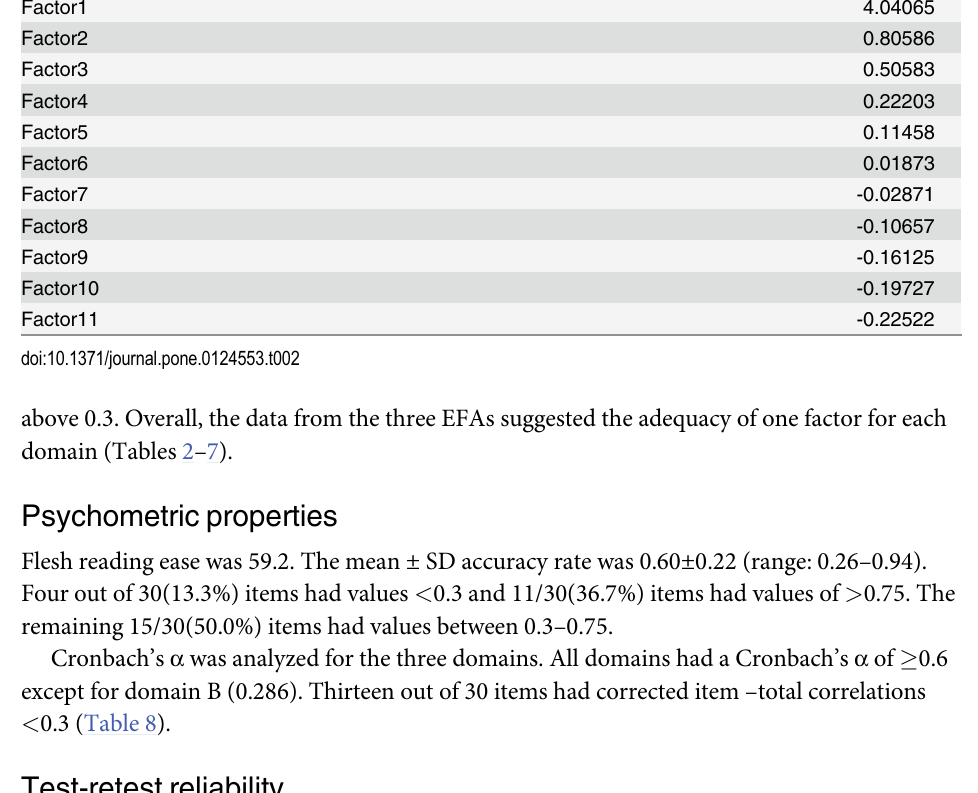
Table 3. Factor loadings of the domain A in the Osteoporosis Prevention and Awareness Tool (OPAAT) using exploratory factor analysis (EFA). Variable